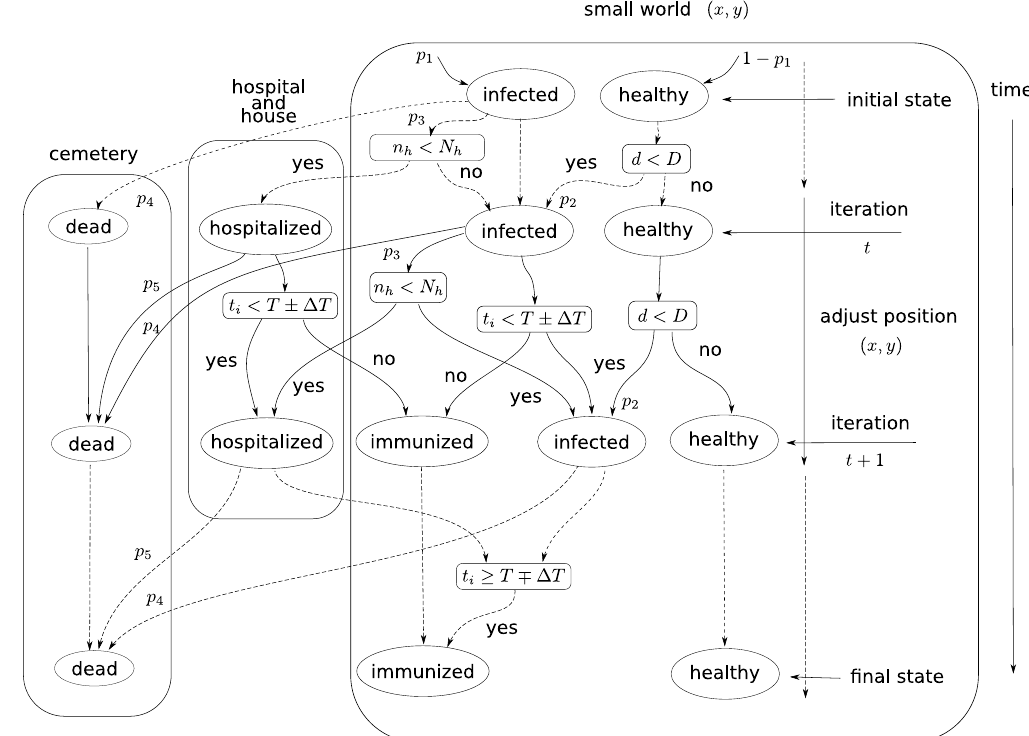
Figure 1. Diagram of the evolutionary epidemic diffusion (EED) involving the five state variables ‘healthy’, ‘infected’, ‘hospitalized’, ‘immunized’ and ‘dead’ and the three locations small world (SW), hospital and